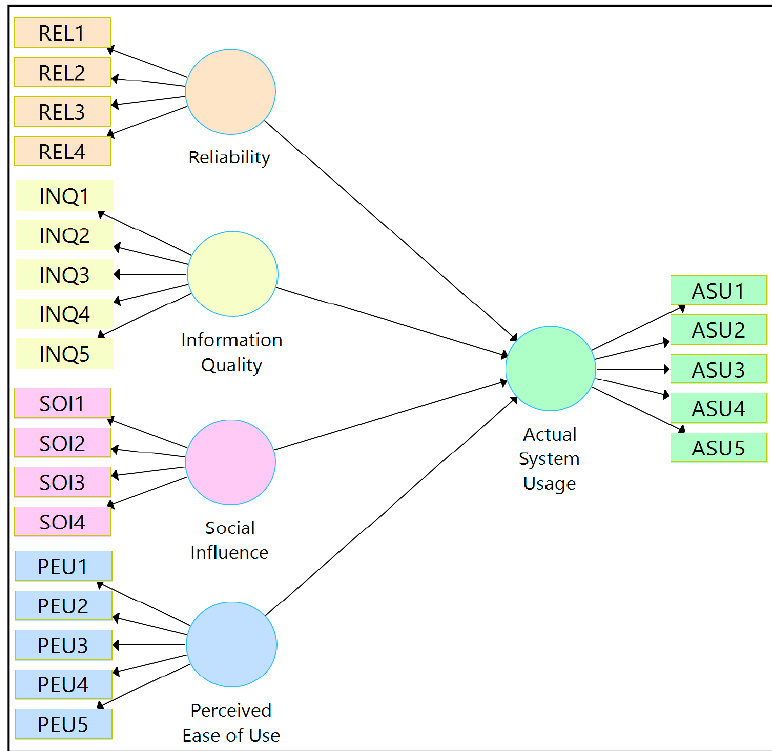
Figure 2. Conceptual model for E-Learning Service Quality.